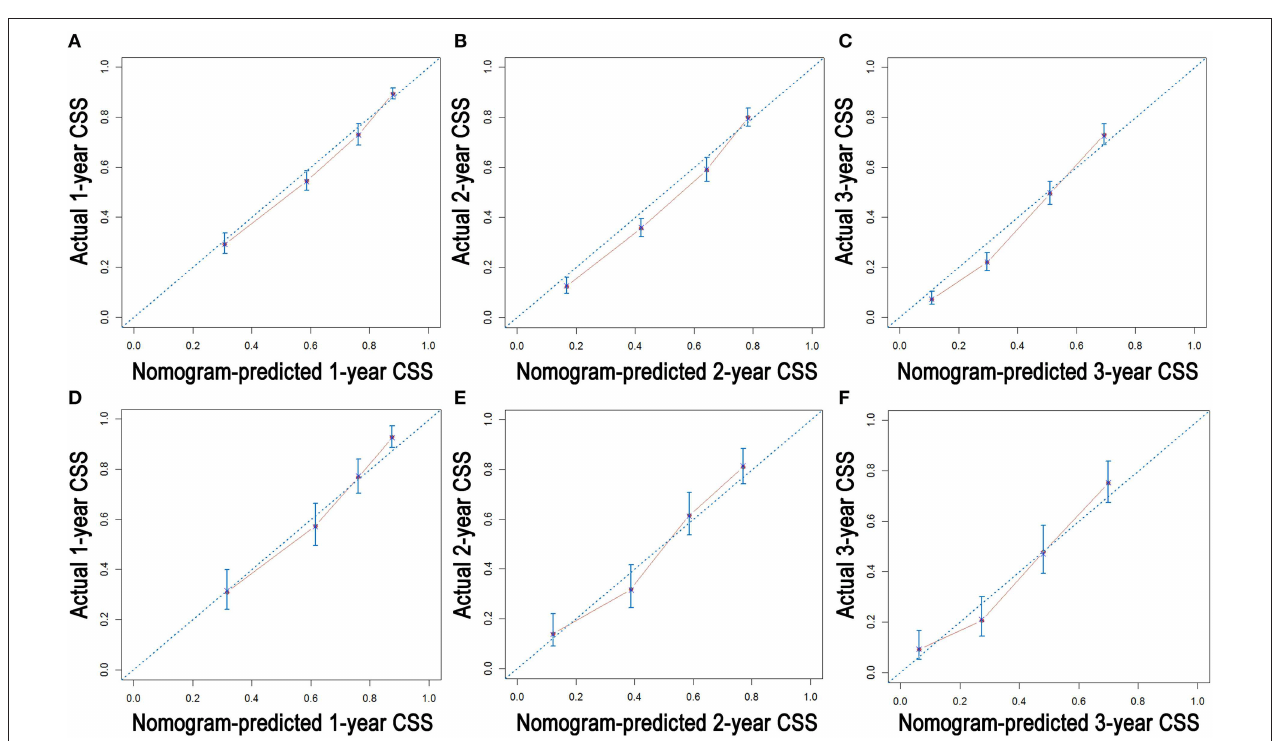
FIGURE 5 | Calibration plots of the nomogram for 1-, 2-, and 3-year CSS prediction of the training cohort (A–C) and internal validation cohort (D–F) .